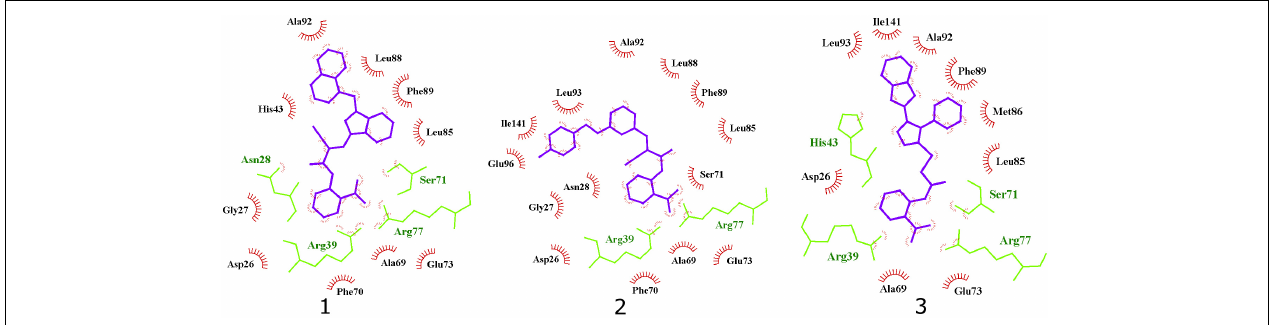
FIGURE 7 | 2D projection of calculated binding modes of reported inhibitors 1–3 in their respective UppS protein binding sites 1. Small-molecules are colored blue, amino acid residues forming polar contacts are green. Residues that form lipophilic contacts with small-molecule are presented in black and red and are partially encircled.